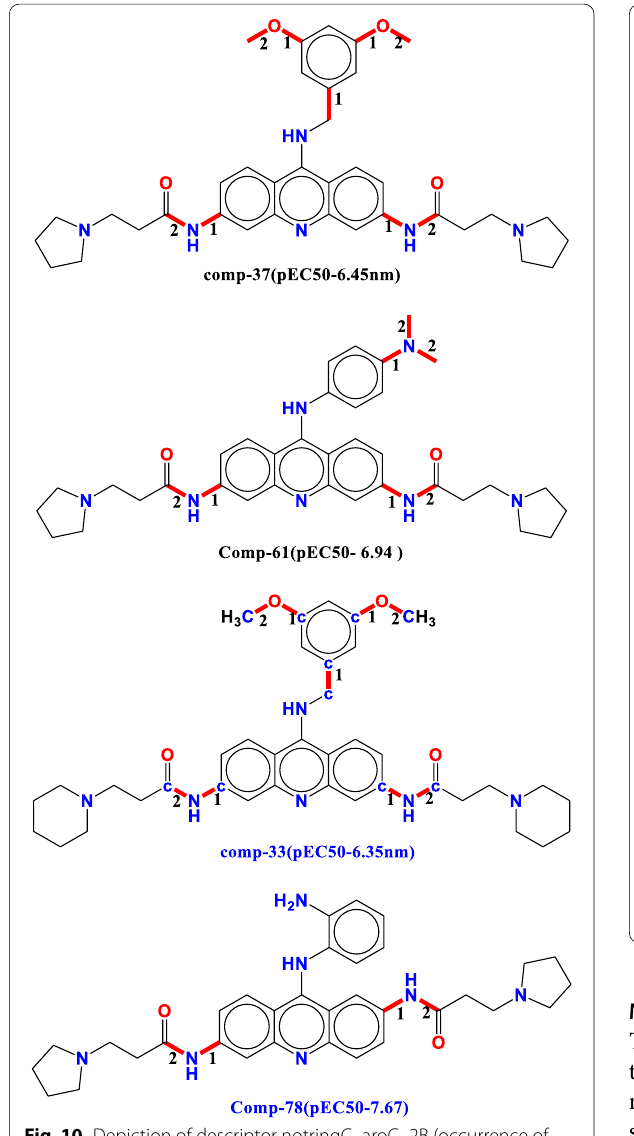
Fig. 10 Depiction of descriptor notringC_aroC_2B (occurrence of nonring carbon atom exactly within 2 bonds from aromatic carbon atom, distance between aromatic and non aromatic carbons are shown by bold red bonds)